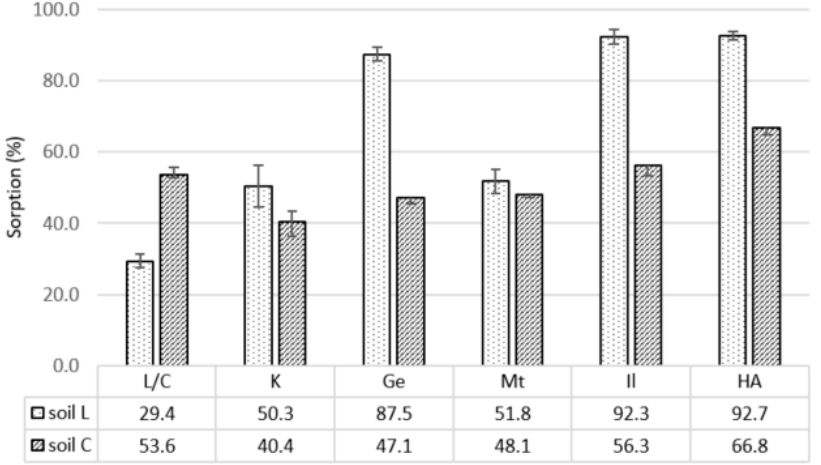
Figure 1. Comparison of carbaryl sorption on soils L and C in the studied variants range. Error bars represent standard deviation of the measurements.